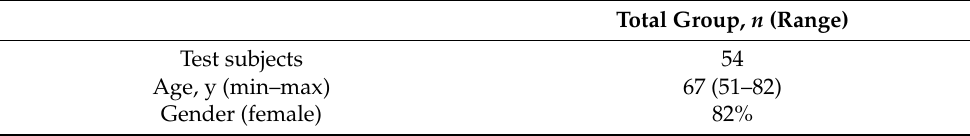
Table 2. Test return frequency from n = 46 intermediate age-related macular degeneration partici- pants with uptake of home monitoring. Days